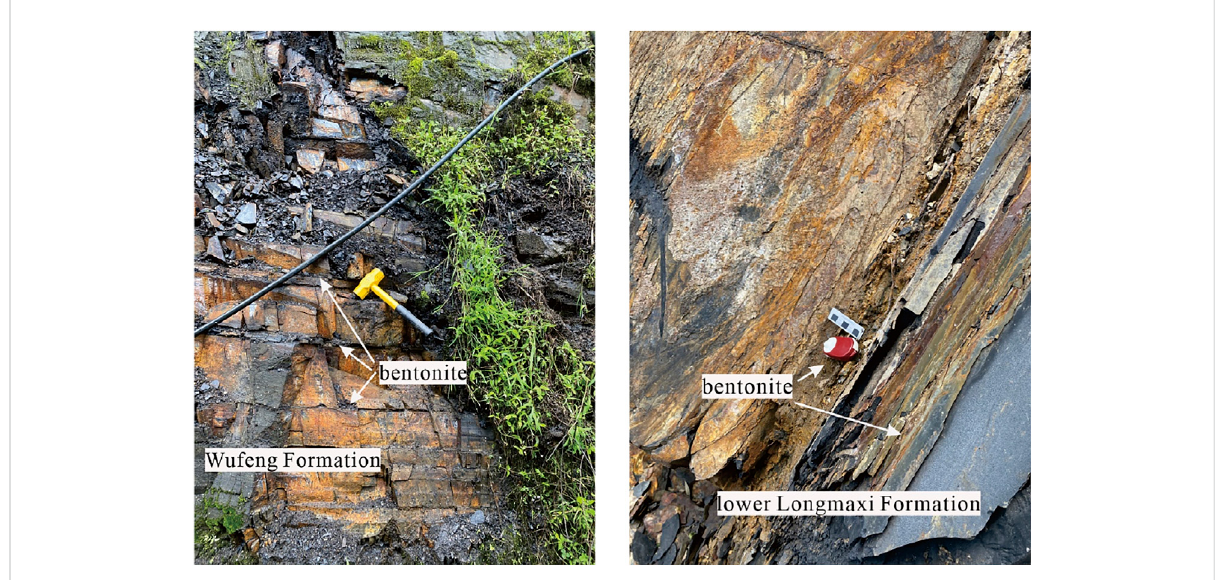
FIGURE 8 Bentonite found in the Wufeng and Longmaxi formations in the Tianlin